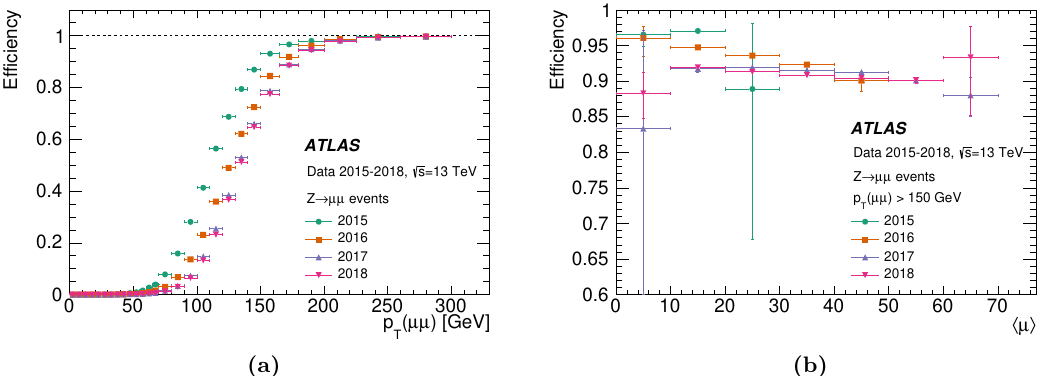
Figure 10. Full-chain trigger e(cid:14)ciencies for each year (a) as a function of p T ( (cid:22)(cid:22) ) and (b) as a function of h (cid:22) i for p T ( (cid:22)(cid:22) ) > 150 GeV. The e(cid:14)ciency corresponds to that of the lowest unprescaled trigger that is adjusted throughout each year (table 2). The uncertainties are statistical.